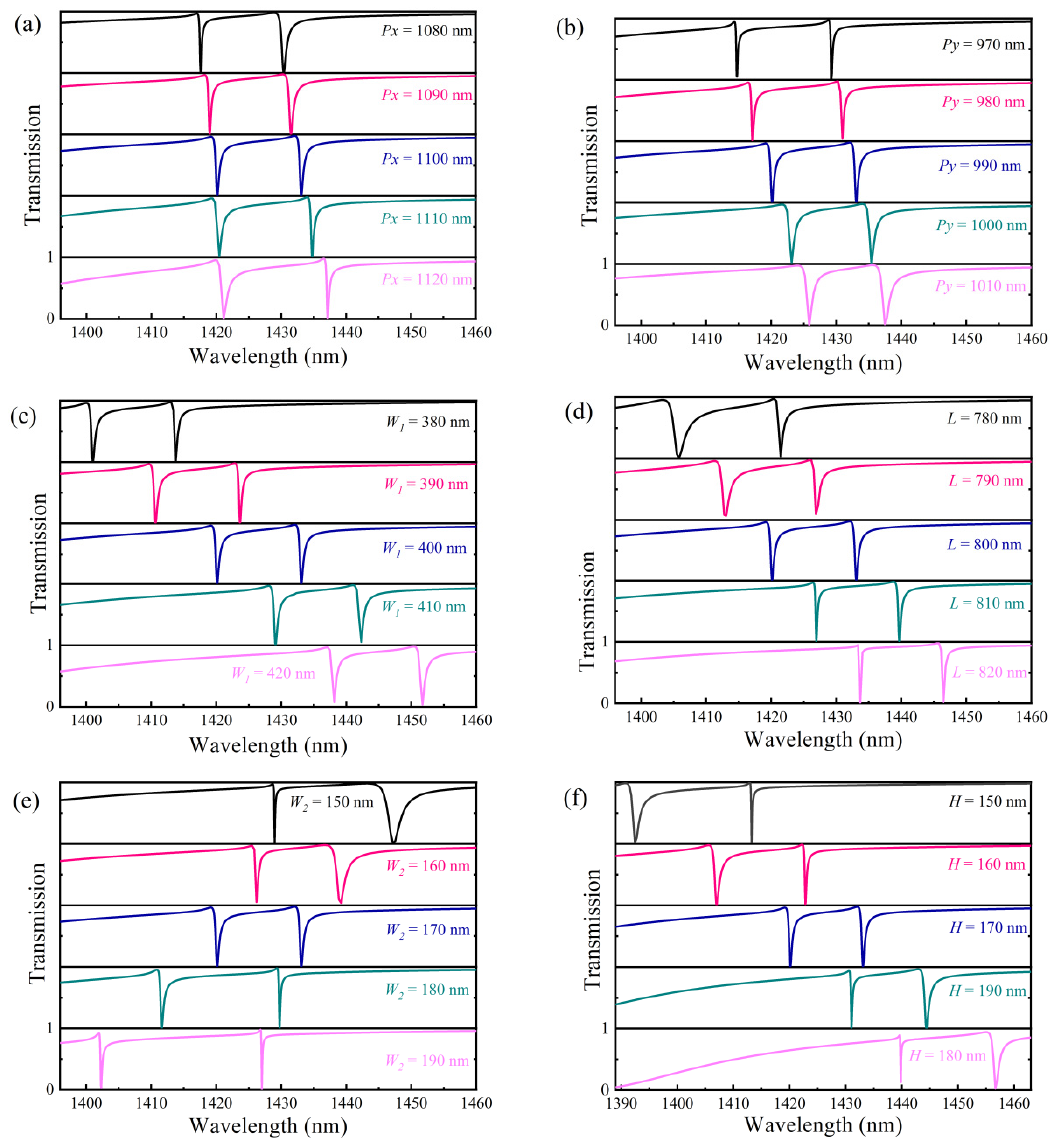
Figure 7. The influence of structural parameters on resonance characteristics. The influence of ( a ) the period Px , ( b ) Py , ( c ) W 1 , ( d ) L , ( e ) W 2 , and ( f ) the height H on the resonance peak.